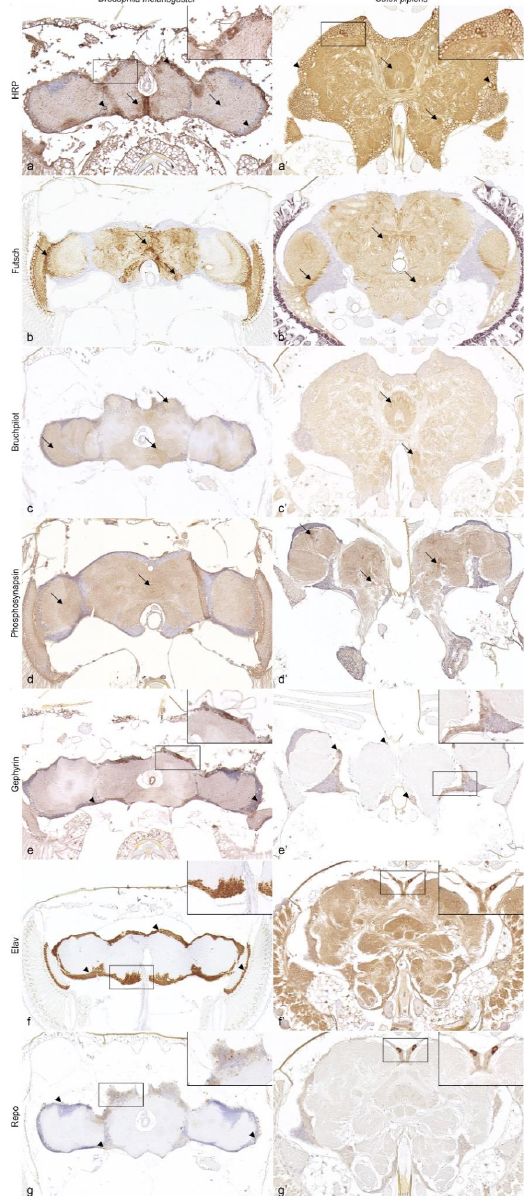
Figure 2. Immunoreactivity of antibodies directed against nervous tissue of Culex pipiens in com- parison with Drosophila melanogaster . Anti-HRP visualizes the entire nervous tissue (cortical cells: arrowheads, neuropil: arrows) in Drosophila melanogaster ( a ) and Culex pipiens ( a’ ), whereas anti-futsch ( b , b’ ), anti-brp ( c , c’ ) and anti-phosphosynapsin ( d , d’ ) mark the neuropil (arrows) in both insects. Note the more defined presentation of axon tracts with anti-futsch in comparison to anti-HRP, anti-brp and anti-phosphosynapsin. Anti-gephyrin ( e , e’ ) presents multifocally immunopositive cell bodies (arrowheads) in Drosophila melanogaster ( e ) and Culex pipiens ( e’ ). While the antibody anti-repo labeled glial cells (arrowheads) in Drosophila melanogaster ( f ), Culex pipiens displayed a false positive bilateral symmetric strong cytoplasmic signal within the protocerebral cortex ( f’ ). Application of anti-elav resulted in a distinctive visualization of neurons (arrowheads) within the ganglial cortex and optic lobes in Drosophila melanogaster ( g ). In contrast, head ganglia as well as optic lobes in Culex pipiens displayed a false positive bilateral symmetric strong cytoplasmic signal within the protocerebral cortex ( g’ ). Magnification × 20, magnification inserts × 40. Brp: bruchpilot; elav: embryonic lethal abnormal vision; HRP: horseradish peroxidase; repo: reversed polarity